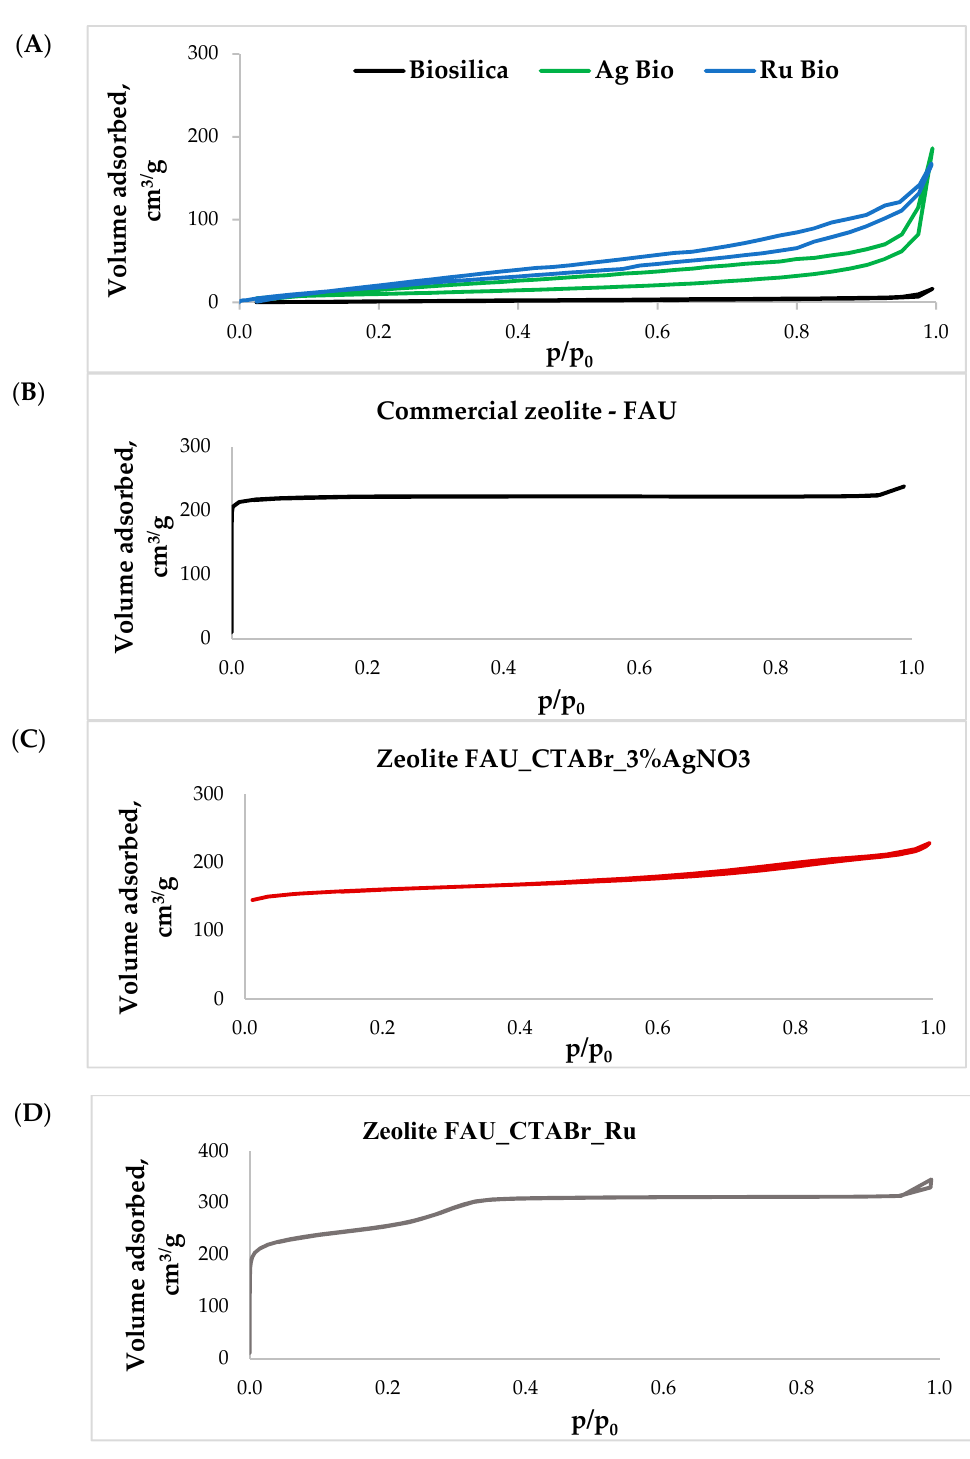
Figure 3. Nitrogen adsorption/desorption isotherms for ( A ) porous materials based on diatom biosilica doped with silver or ruthenium ions, ( B ) FAU-type commercial zeolite, ( C ) for hierarchical zeolite based on FAU-type commercial zeolite modified with silver ions, ( D ) hierarchical zeolite based on FAU-type commercial zeolite modified with ruthenium ions.